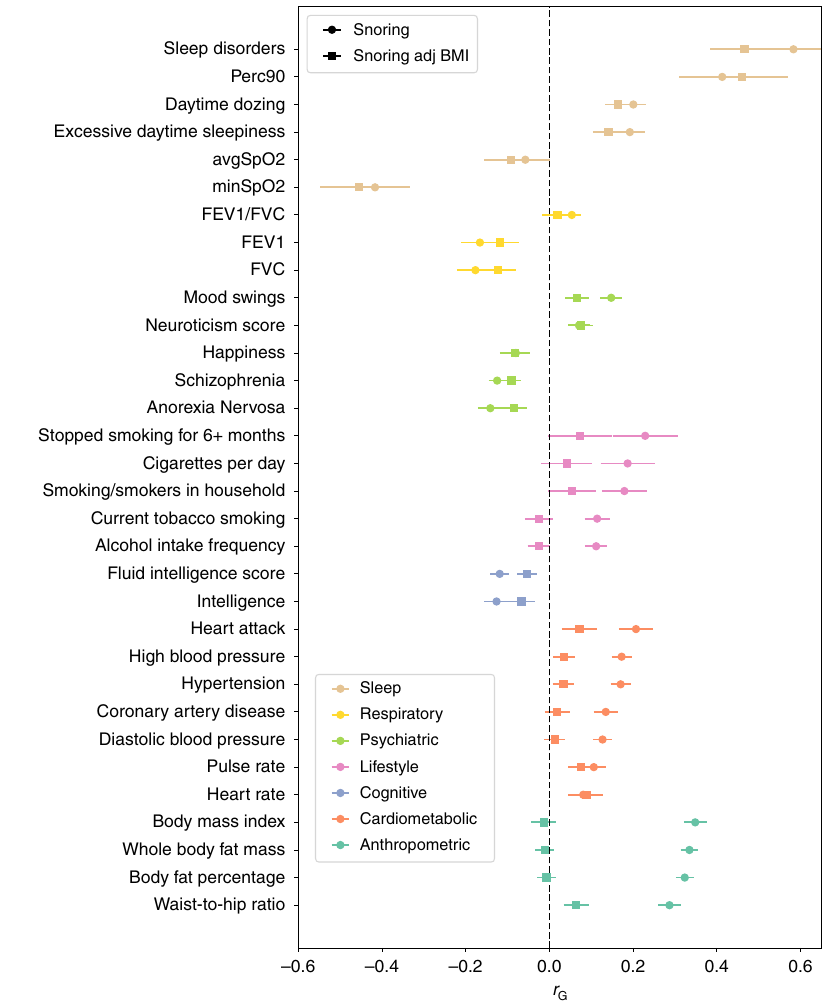
Fig. 3 Snoring is genetically correlated with lifestyle, psychiatric and respiratory traits. LD score-based estimates of the genetic correlation between snoring (circles) or snoring adjusted for BMI (squares) and other complex traits ( y -axis). All of the depicted traits had a statistically signi fi cant genetic correlation with snoring after multiple testing correction (Benjamini – Hochberg; FDR < 0.05). Error bars show the SE of the genetic correlations. Not all tested associations are shown due to lack of space; complete results are available in Supplementary Data